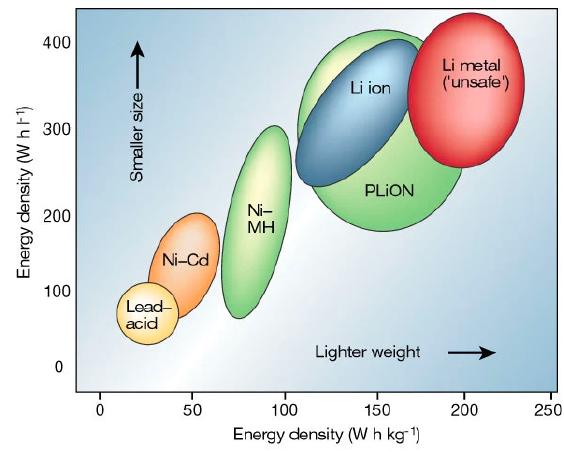
Figure 1. Ragone plot of lithium batteries [15].